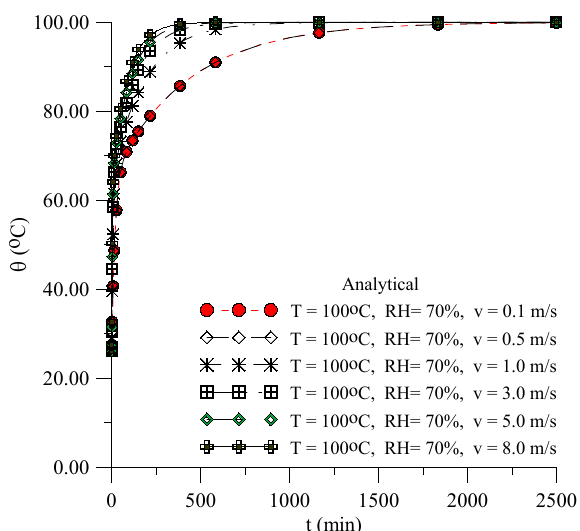
Figure 10. Temperature at the vertex of the industrial ceramic brick as a function of time for different drying air speeds.